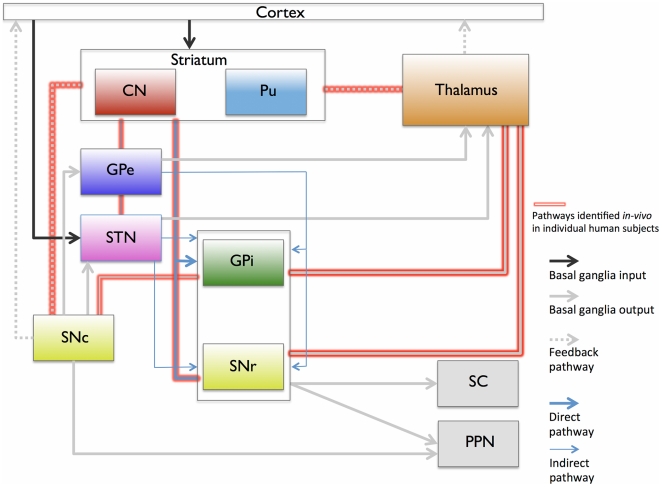
Basal ganglia and thalamus circuits, and newly identified pathways in-vivo in individual human subjects.The diagram, adapted from [7], summarizes known pathways of the basal ganglia and thalamus connectome, from histology and recent MRI population studies. The lines outlined in red indicate pathways uniquely identified in-vivo in individual human subjects in this study using 7T MRI. Although the directionality (afferent/efferent) of these pathways is known from histology, diffusion MRI tractography is unable to recover this information, hence the absence of polarity for the pathways identified in this study.